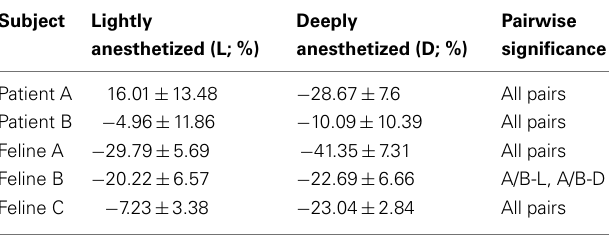
Table 1 | Percent change in average power of a 30-s time window in the high gamma band (60–120Hz) with respect to the baseline or awake state for all electrodes ( N = 96; mean ±